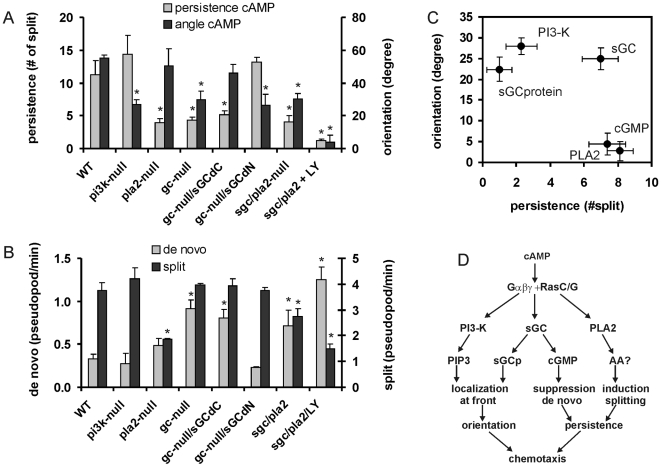
Pseudopod formation in mutants.Mutants with one or multiple mutations were exposed to a shallow cAMP gradient, and analyzed for pseudopod extensions (see table S1 for statistics and additional properties). Panel A shows the persistence and orientation. Persistence is expressed as the number of persistent steps in between two de novo pseudopodia, based on the frequencies of split and de novo pseudopodia shown in panel B. The orientation is expressed as the maximal correction of splitting pseudopodia as defined in Figure 3C. Data of panels A and B show the means and SEM of 12 wild type cells and 7 or 8 mutant cells, *, significantly different from wild type at P<0.05. C, the contribution of each signaling pathway to persistence and orientation was calculated by taking the difference of two data sets as follows: PI3K, average of difference of WT and pi3k-null, and difference between sgc/pla2-null and sgc/pla2-null + LY; PLA2, difference of WT and pla2-null; sGC, difference of WT and gc-null; sGCp (sGC-protein), average of difference of gc-null and gc-null/sGCΔCat, and difference of WT and gc-null/sGCΔN; cGMP, average of difference of gc-null and gc-null/sGCΔN, and difference of WT and gc-null/sGCΔCat. D, Model of signaling pathways leading to persistence and orientation. cAMP activates heterotrimeric- and Ras GTP-binding proteins through surface receptors. The activated PI3K and sGC-protein (sGCp) accumulate at the leading edge where they regulate orientation, which is the position and direction in which the pseudopod is extended. The product of sGC, cGMP, suppresses de novo pseudopodia predominantly in the rear of the cell, while the product of PLA2, probably arachidonic acid (AA), induces pseudopod splitting; both pathways lead to persistence of pseudopod extension in the direction of previous pseudopodia.